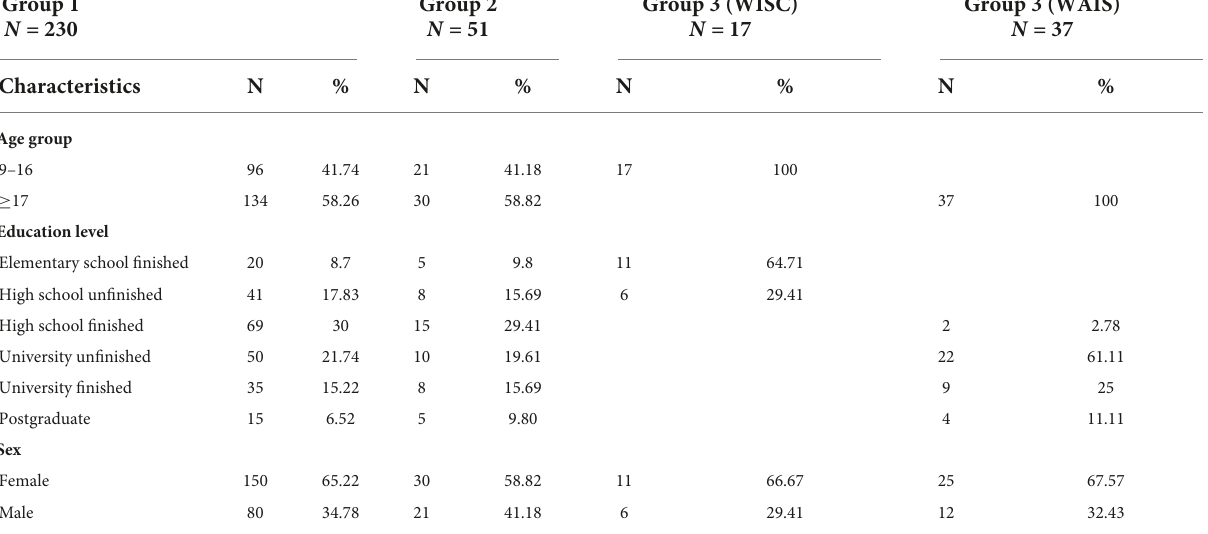
TABLE 4 Sociodemographic